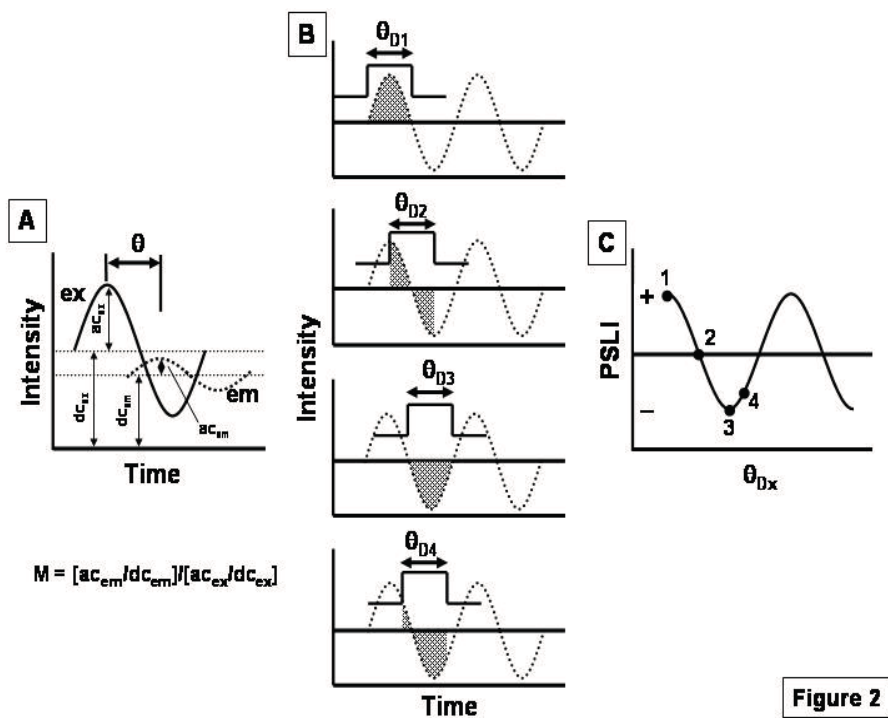
Figure 2. A basic phase resolved experiment. ( A ) Phase-modulation concept. Excitation (ex), emission (em), luminescence phase shift ( θ ), and luminescence demodulation factor ( M ) are shown; ( B ) The phase resolution experiment with the detector phase angle ( θ Dx ) set at four different values ( θ D1 to θ D4 ). The shaded region denotes the area under